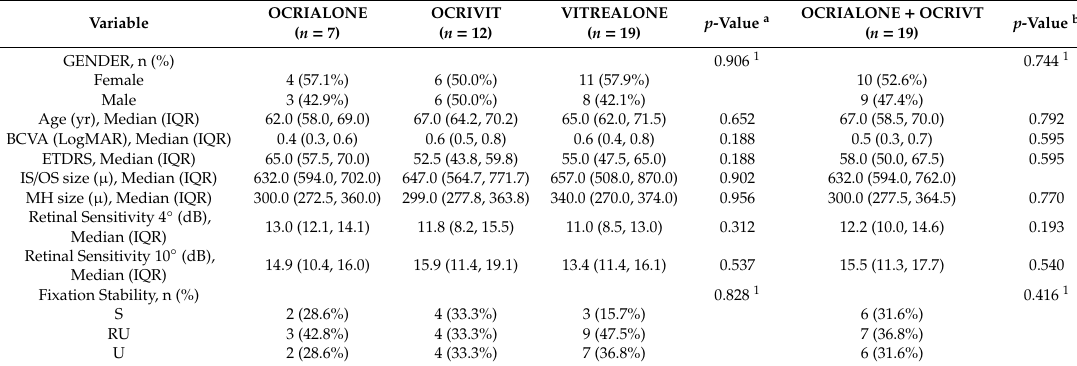
Figure 1. ( A ), baseline optical coherence tomography scan of a patient in the OCRIVIT group who failed the treatment with ocriplasmin (as shown in ( B ) at 1 month follow up) and underwent vitrectomy 1 month later with macular hole closure. Figure ( C ) shows the anatomical result 3 months after surgery. In the middle line, ( D ) shows the baseline characteristics of a patient with macular hole in the OCRIALONE group and ( E ) the macular hole closure after a single ocriplasmin injection 3 months after treatment. Bottom line, ( F ) baseline scan of a patient with macular hole in the VITREALONE and ( G ) shows results 3 months after prompt vitrectomy and gas injection. Table 1. Baseline characteristics of patients enrolled .